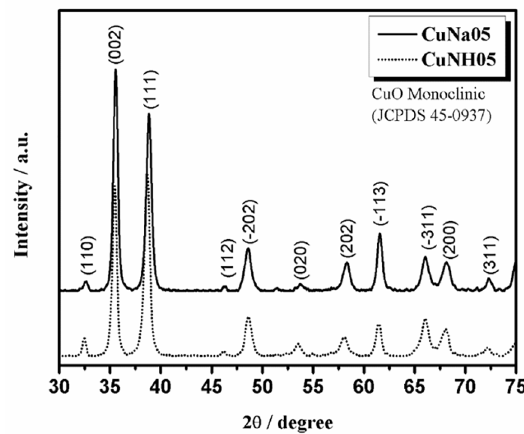
Figure 2 . XRD patterns of CUNa05 and CuNH05 samples obtained at 130 °C for 5 minutes.